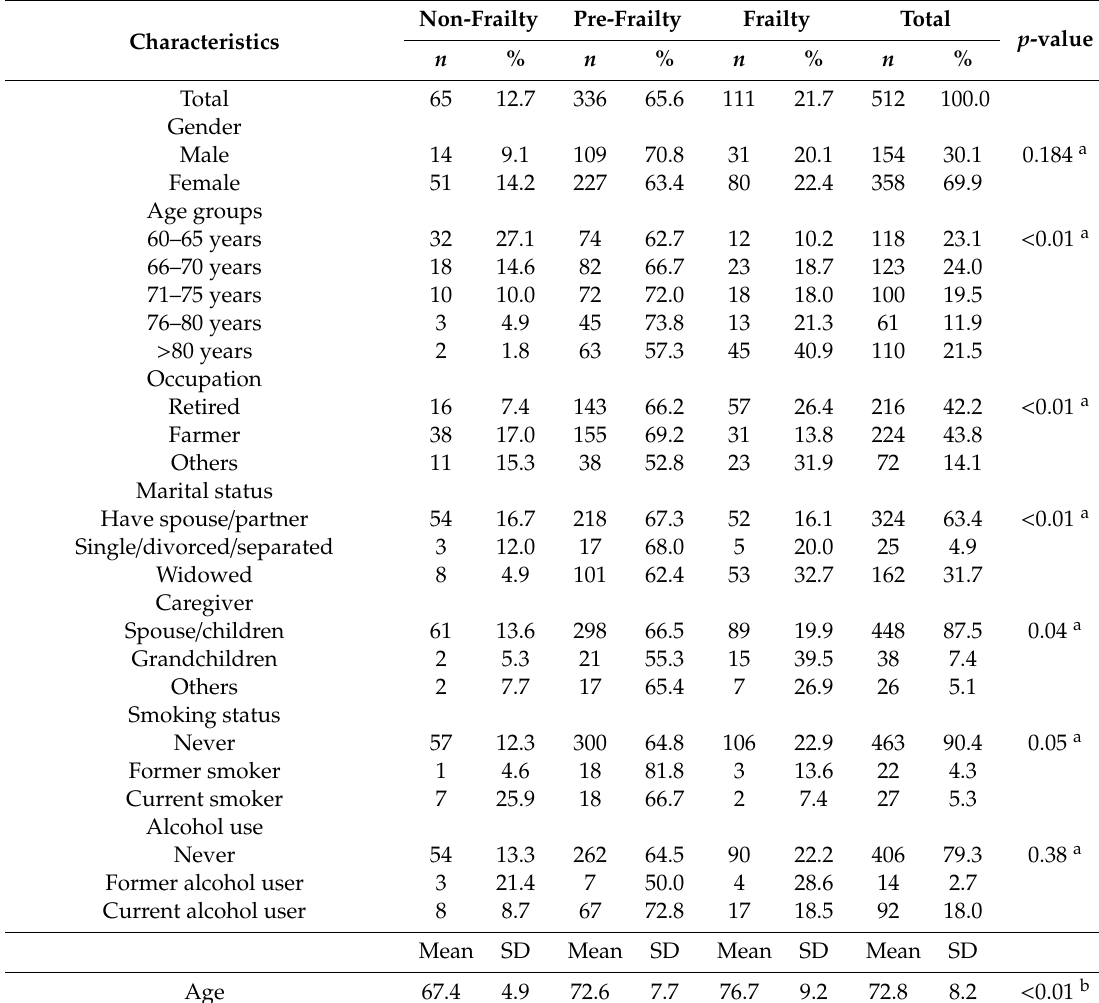
Table 1. Demographic characteristics of respondents.